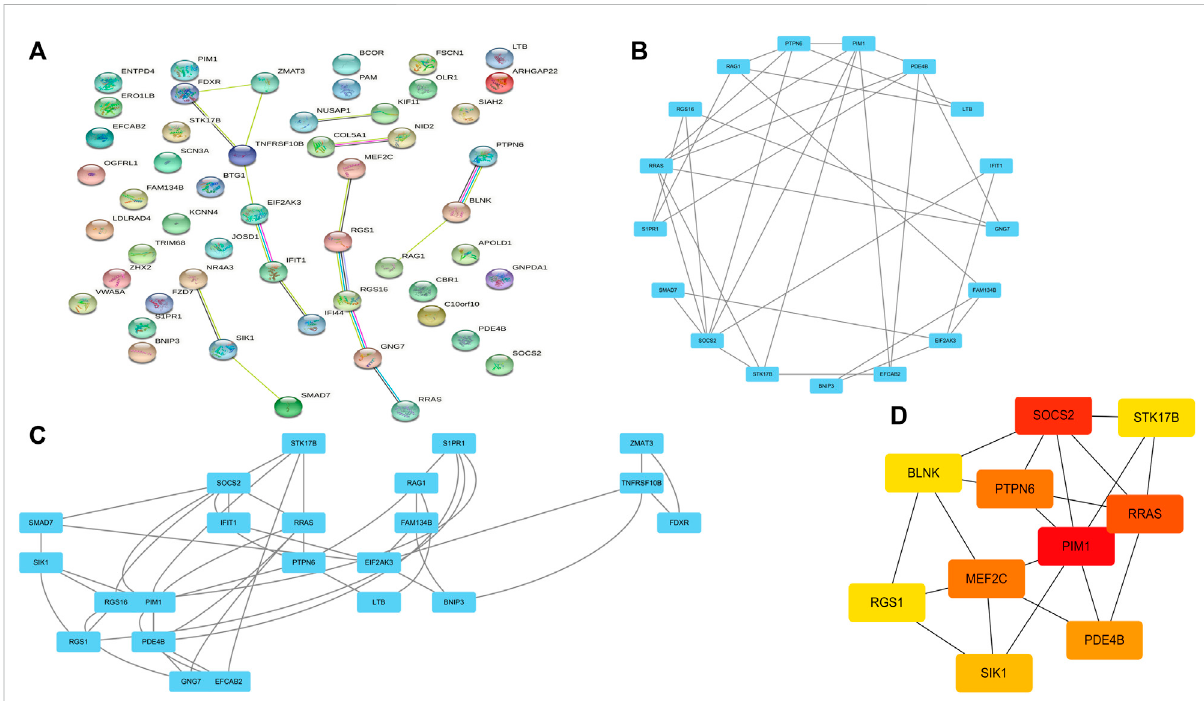
FIGURE 4 PPI network construction and functional module analysis. (A) PPI network; (B) Module 1; (C) Module 2; (D) 10 hub genes of PPI network.